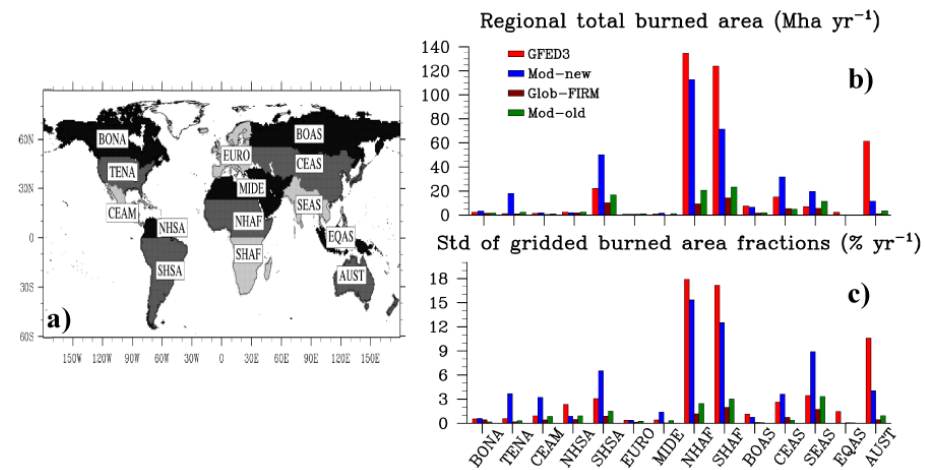
Fig. 9. (a) Map of 14 regions used in this study (left), after Giglio et al. (2006, 2010), van der Werf et al. (2006, 2010) and Kloster et al. (2010); (b) GFED3 and simulated regional annual burned area and (c) standard deviation of gridded burned area fraction in each region. BONA: Boreal North America; TENA: Temperate North America; CEAM: Central America; NHSA: Northern Hem. South America; SHSA: Southern Hem. South America; EURO: Europe; MIDE: Middle East; NHAF: Northern Hem. Africa; SHAF: Southern Hem. Africa; BOAS: Boreal Asia; CEAS: Central Asia; SEAS: South East Asia; EQAS: Equatorial Asia; AUST: Australia.